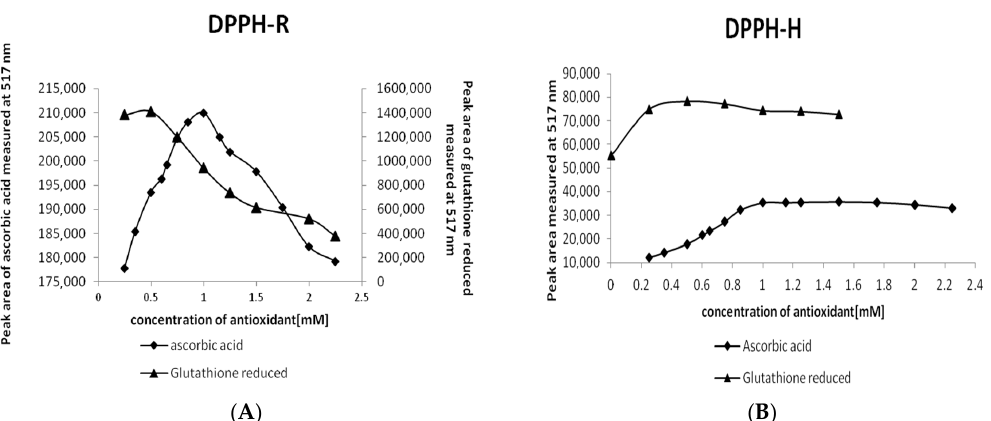
Table 3. Linear regression parameters for the detection conditions of AOs by DPPH-R quench at 517 nm. Concentration of DPPH-R was 0.5 mM.